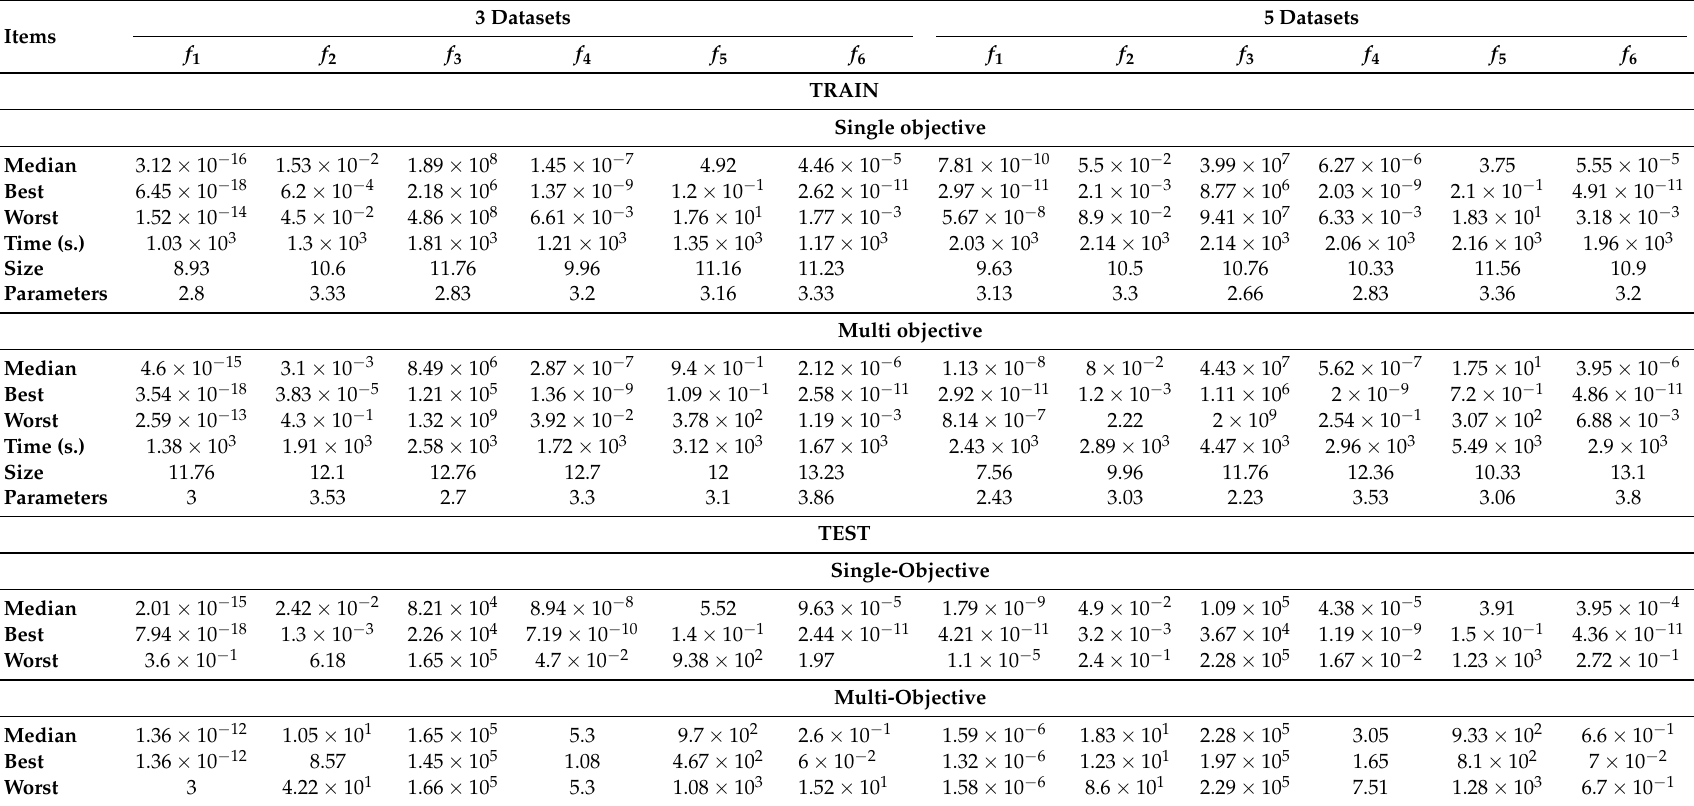
Table 1. Results of Single and Multi objective approaches in benchmark train and test